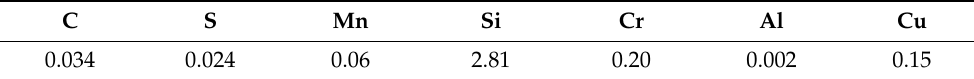
Table 1. Chemical composition of the cast investigated (mass